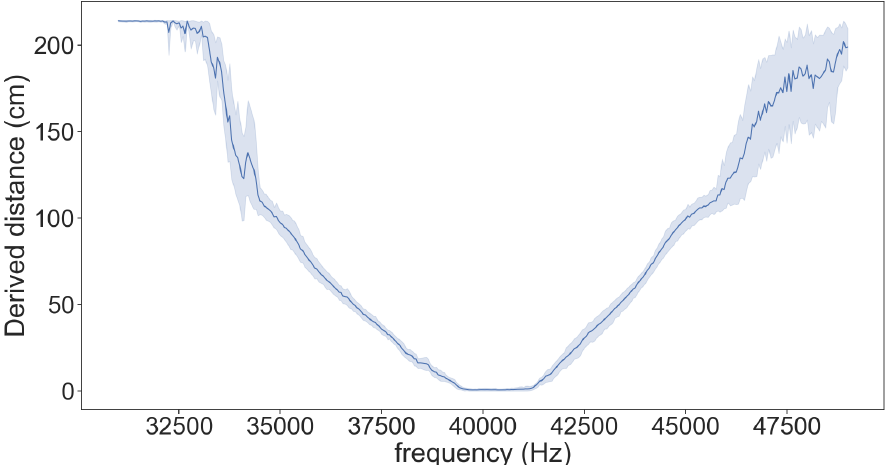
Figure 8. Evaluation of the transferability of the attack between different sensors of the same type. The graph presents the error deviation of the perceived distance when determining the attack parameters of one HC-SR04 sensor and then testing the attack on eight other HC-SR04